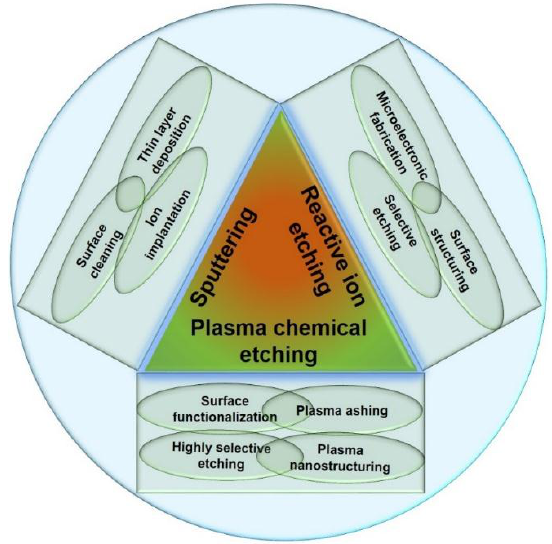
Figure 1. Schematic representation of various uses of different plasma processes.